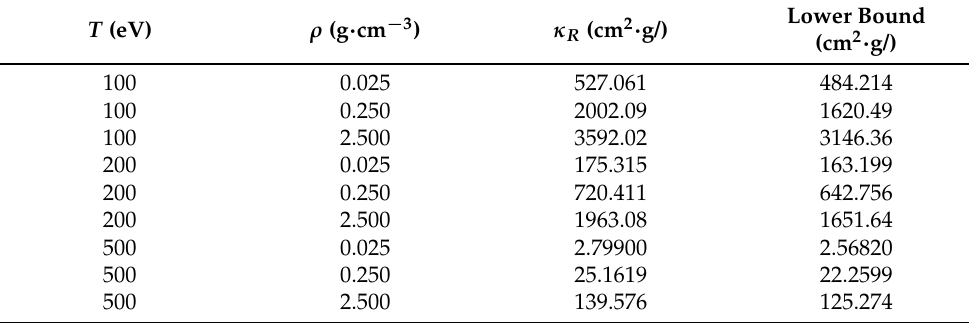
Table 7. Rosseland mean opacity and lower bound (see Equation (24)) for a mixture plasma (number fractions of Fe and Mg are both equal to 0.5) at different temperatures (100, 200, and 500 eV) and densities (0.025, 0.25, and 2.5 g cm − 3 ). These partial densities are obtained by applying the same · electronic pressure to all ions in the plasma [33,34].